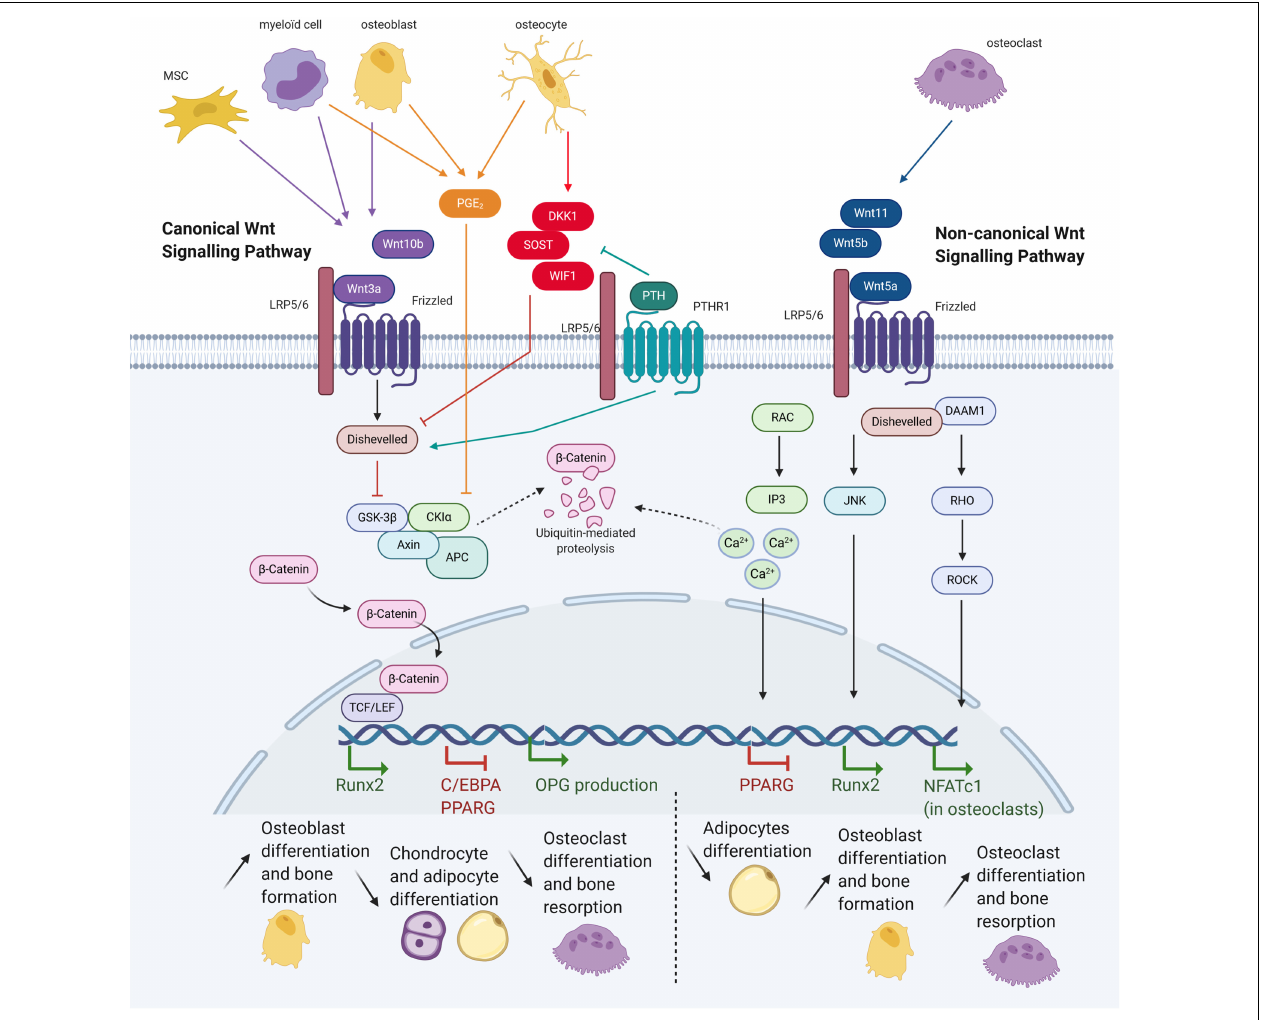
FIGURE 3 | Wnt pathway in osteoblast and consequences on bone cells differentiation. Mesenchymal stem cells (MSCs), myeloid cells, osteoblasts, osteoclasts, and osteocytes express different molecules, triggering or inhibiting the canonical or non-canonical Wnt signalings. Both signalings allow translation of different genes, having consequences for cells commitment and bone activity (Adapted from Baron and Kneissel,